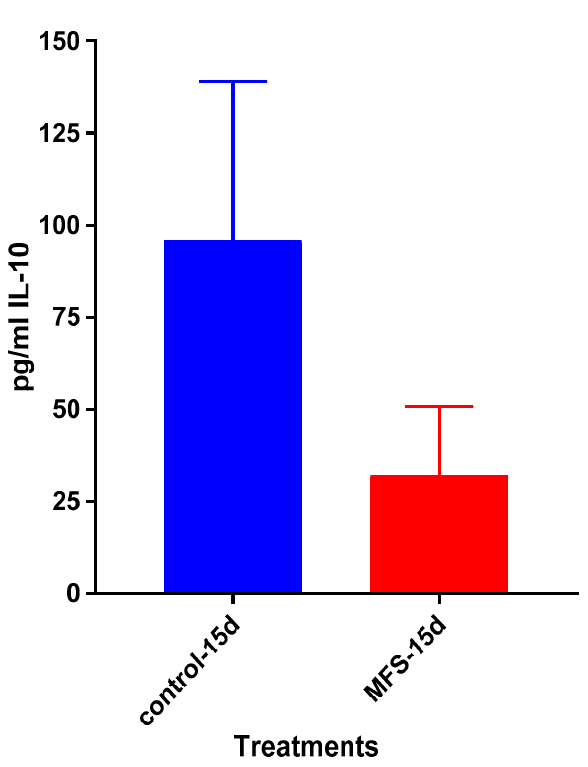
Figure 11. Assay of IL-10 in the supernatants from untreated and MFS-treated granulomas from healthy subjects. Assay of IL-10 was performed using an ELISA Ready-Set-Go kit from eBioscience. Data represent means ±SE from eight healthy individuals.